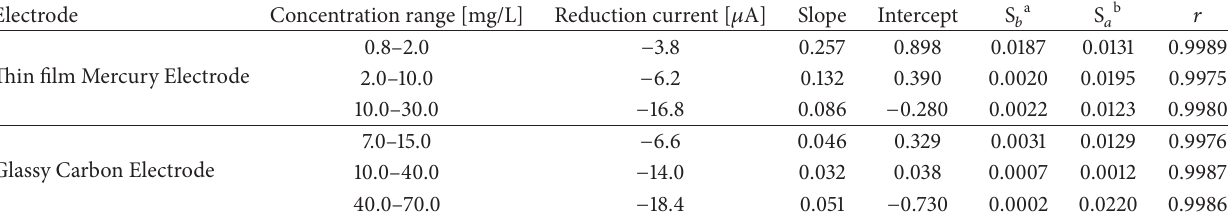
Table 1: Linear ranges for chronopotentiometric determination of imidacloprid using thin film mercury and glassy carbon electrode.